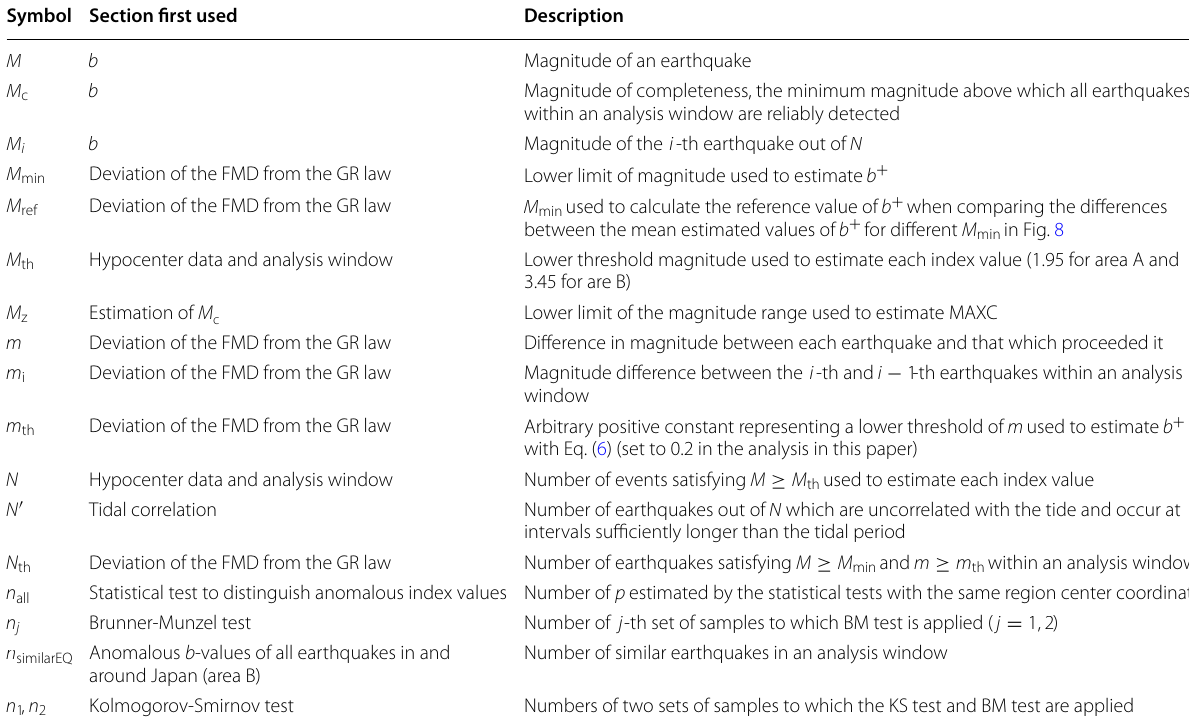
Table 1 Mathematical symbols related to magnitude and number of events Symbol Section first